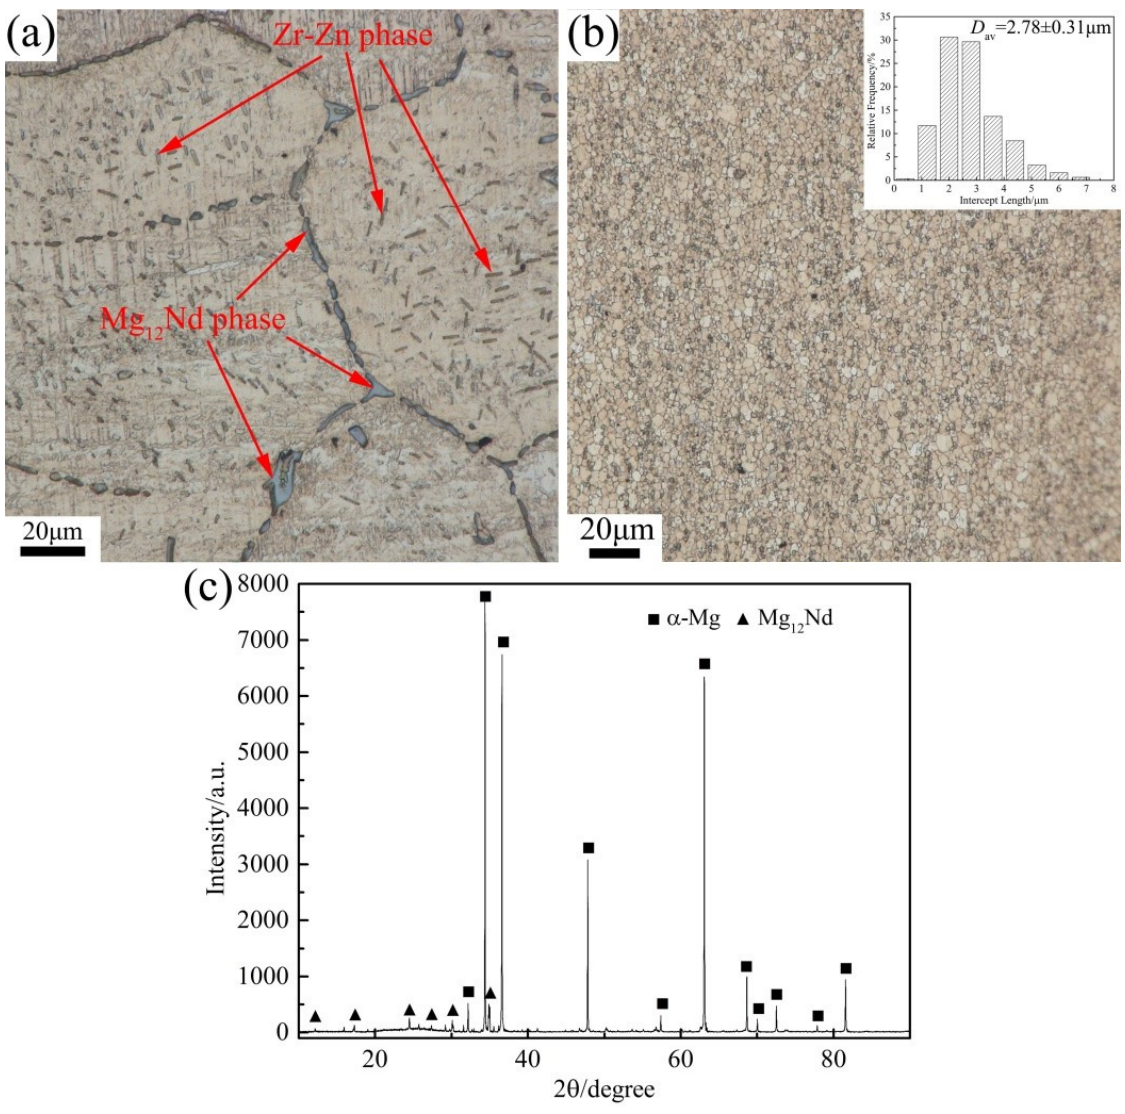
Figure 1. Optical micrograph of the alloy ( a ) as-cast after preheating at 400 ◦ C for 9 h, ( b ) after extrusion at 400 ◦ C, and ( c ) its corresponding XRD patterns.